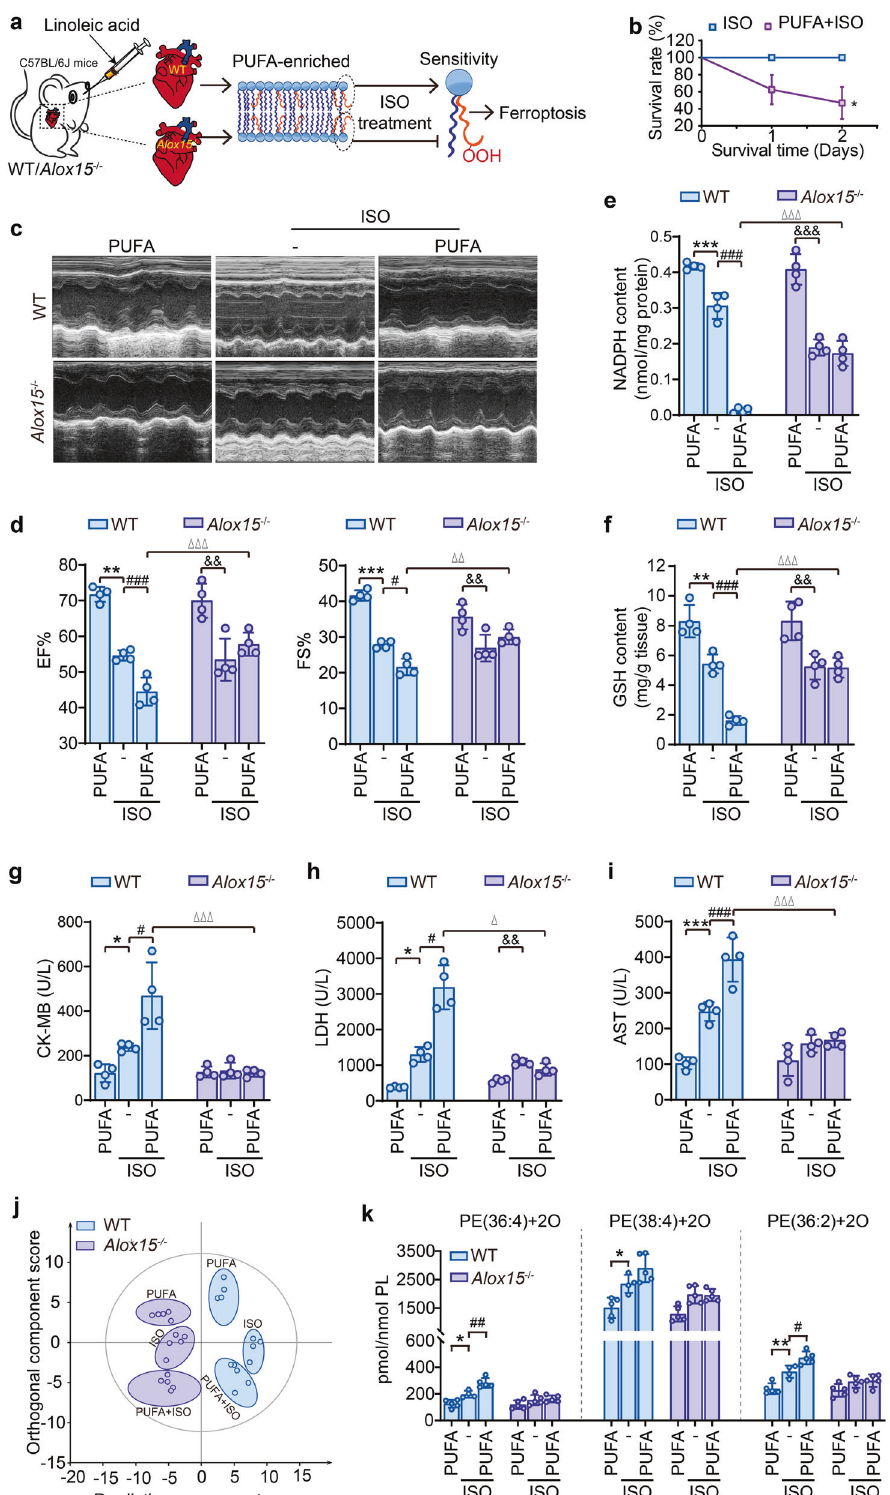
subsequent occurrence of ferroptosis. This surprising discovery shifts attention from common free radicals to lipoxygenase- mediated speci fi c-oxidative response, thus overturning the long- held opinion that oxidative damage is only presented at the reperfusion